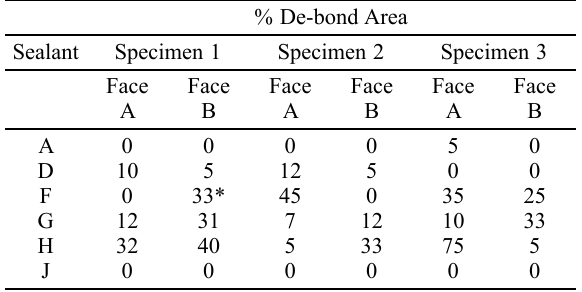
Table 2. Percent de-bond area on cement mortar and steel substrates in relation to sealant types Mortar substrate (+25% extension at –50 °C)